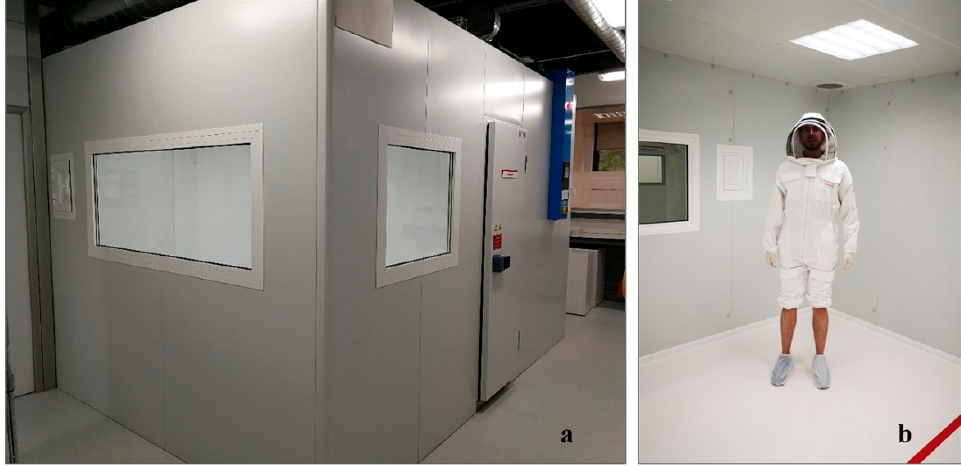
Figure 1. ( a ) The 30-m 3 testing chamber at Henkel’s R&D Laboratory. ( b ) Participant wearing a protective suit while inside the chamber.